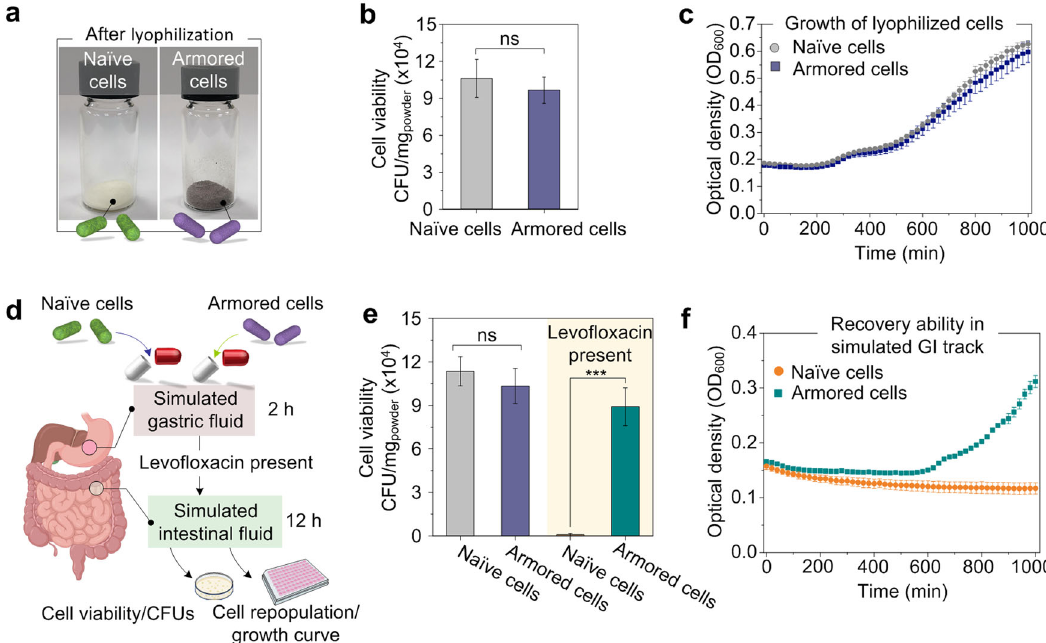
Fig. 4 Encapsulation of lyophilized bacteria and cell recovery in simulated GI conditions. a Images of lyophilized powders of naïve EcN and armored EcN. b CFU of naïve or armored EcN after lyophilization. Statistical comparisons were performed using two-tailed unpaired t -tests ( n = 3), p = 0.559161> 0.05. c Growth curve of naïve or armored EcN after lyophilization in the timescale of 1800 min. d Schematic of the enteric capsule fi lled with bacteria used for the experiments with simulated gastric and intestinal fl uids. e CFU of naïve or armored EcN after encapsulation in enteric capsules and treatment with simulated gastric and intestinal fl uids in the presence or absence of levo fl oxacin. Statistical comparisons were performed using two-tailed unpaired t -tests ( n = 3). For the groups without levo fl oxacin, p = 0.448823 > 0.05, ( n = 3). For the groups with levo fl oxacin, p = 0.000669 < 0.001. f Growth curve of naïve or armored EcN after recovery from the simulated intestinal fl uid containing levo fl oxacin in the timescale of 1800 min. ns p -value > 0.05, * p -value < 0.05; ** p -value < 0.01; *** p -value < 0.001. The graphs of panels b and e represent mean values± standard error of mean. Signi fi cant differences between mean values were evaluated using ANOVA with multiple